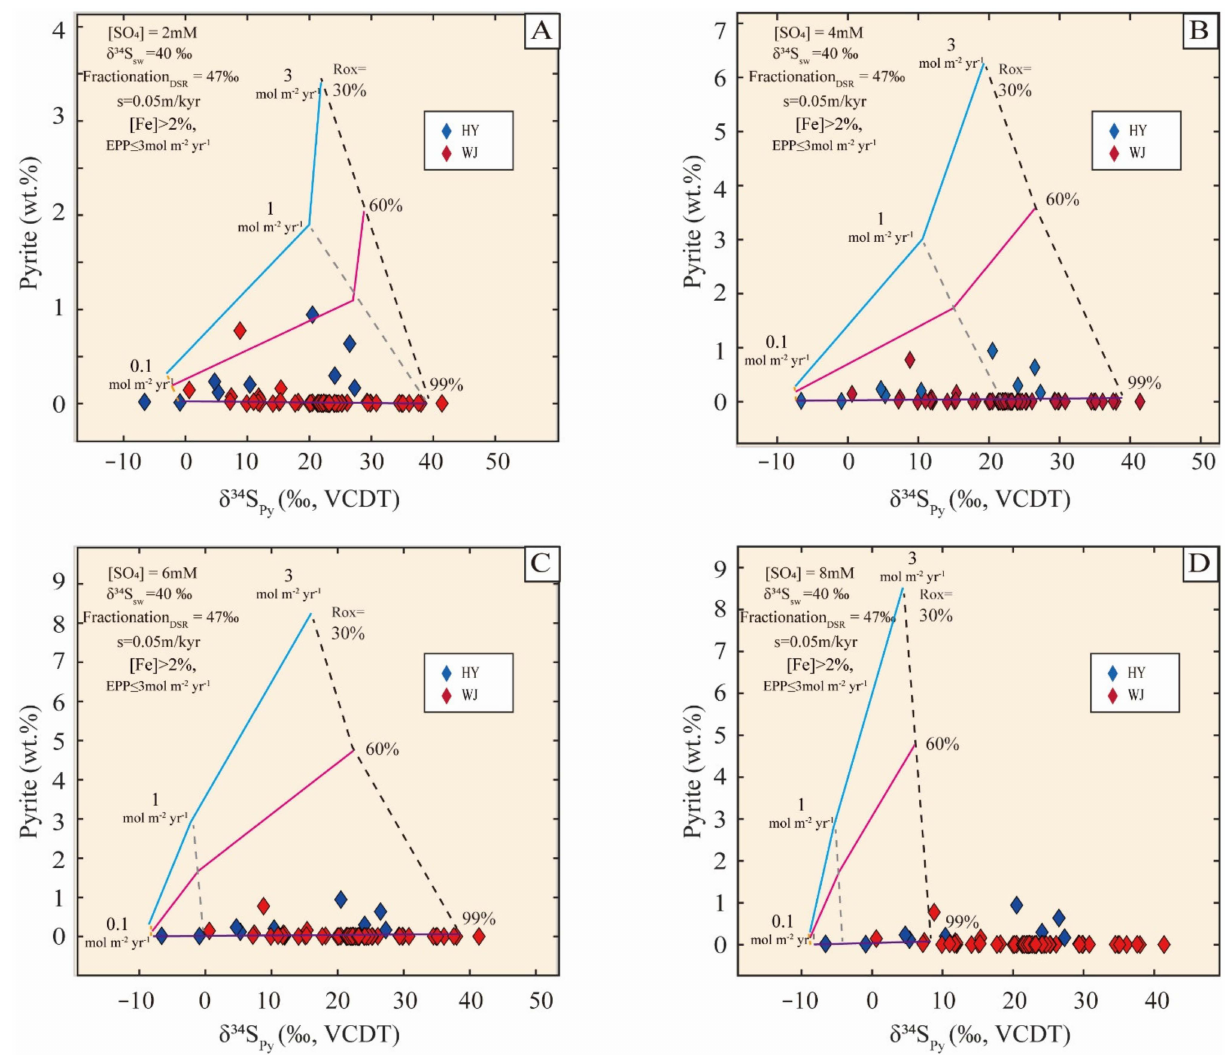
Figure 5. Modeling results for sulfate concentrations in shallow water during the E–C transition. ( A ) The modeling results show a value of 2 mM in shallow water. ( B ) The modeling results show a value of 4 mM in shallow water. ( C ) The modeling results show a value of 6 mM in shallow water. ( D ) The modeling results show a value of 8 mM in shallow water. In the figures, the horizontal axis represents the pyrite sulfur isotopic composition, and the vertical axis indicates the pyrite content. The blue, pink, and purple solid lines indicate that the proportion of H 2 S reoxidation was 30%, 60%, and 99%, respectively. The orange, gray, and black dashed lines indicate that the organic matter flux was 0.1, 1, and 3 mol/m 2 /yr, respectively. The boundary conditions of the model are shown in the figures. The data in the Wangji section are taken from